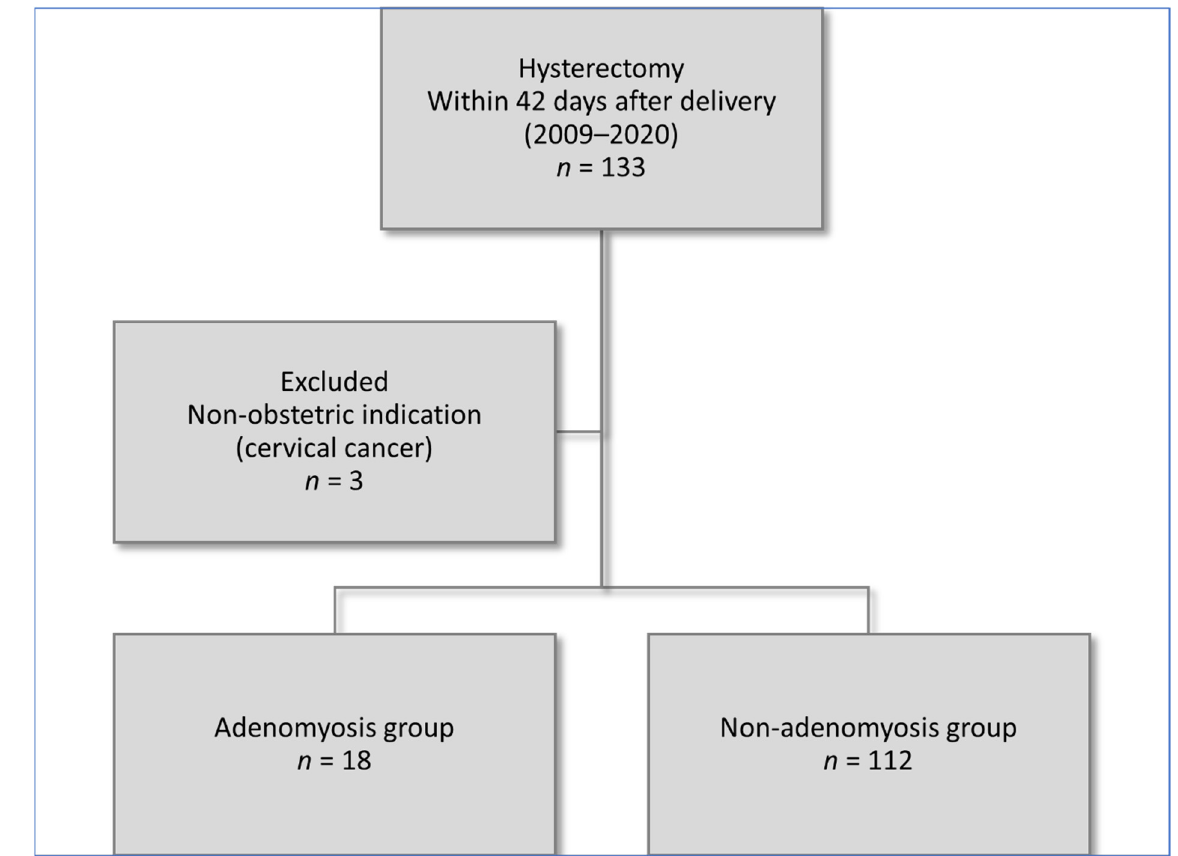
Figure 1. Flow diagram of study population.